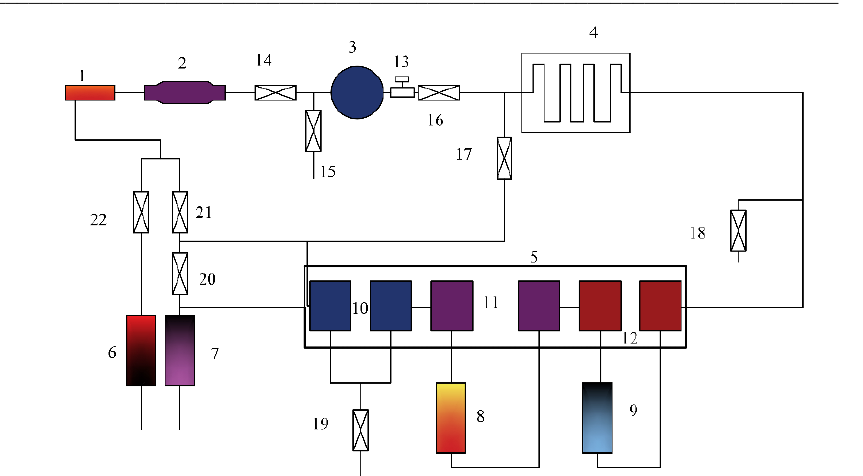
Fig. 4. The flow schematic diagram of CHNS analyser: 1) Combustion tube; 2) Reduction tube; 3) Mixing Volume; 4) Sample volume; 5) Thermal conductivity detector; 6) Scrubber (Oxygen supply); 7) Scrubber (Helium supply); 8) CO 2 trap; 9) H 2 O trap; 10) Nitrogen capture; 11) Carbon capture; 12) Hydrogen capture; 13) Pressure transducer; 14) Cut-off valve between the combustion train and the analytical system; 15 and 16) Purge valve; 17) Exhaust valve; 18) Gas control valve; 19 and 20) Automatic leak testing valves: 21) Solenoid valve; 22) Oxygen flow control